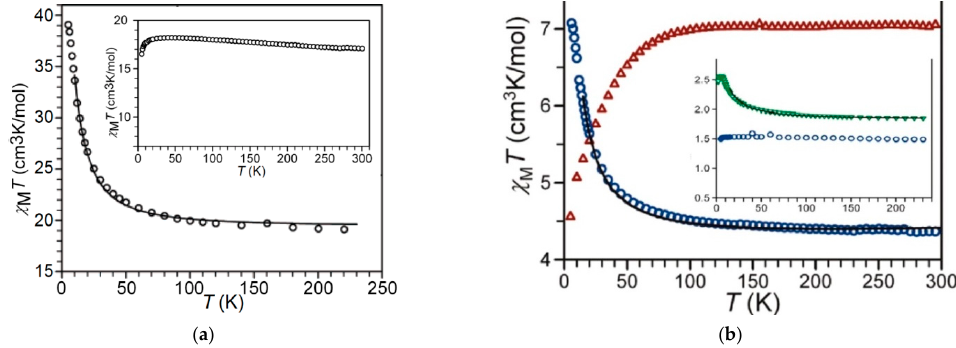
Figure 2. Variable temperature of the dc magnetic susceptibility data obtained in a field of 1000 Oe in the range of 2–300 K: ( a ) for 4 and 5 (inset); the solid line is a simulation plot with J = + 2.3 cm − 1 and g = 2.00 [3]. ( b ) 6 (red) and 7 (blue). Inset: χ T plots for Cu 4 Re species 8 (green) and 9 (blue); the black plots are a simulation resulting in J = + 4.4 and + 6.26 cm − 1 for 7 and 8 , respectively